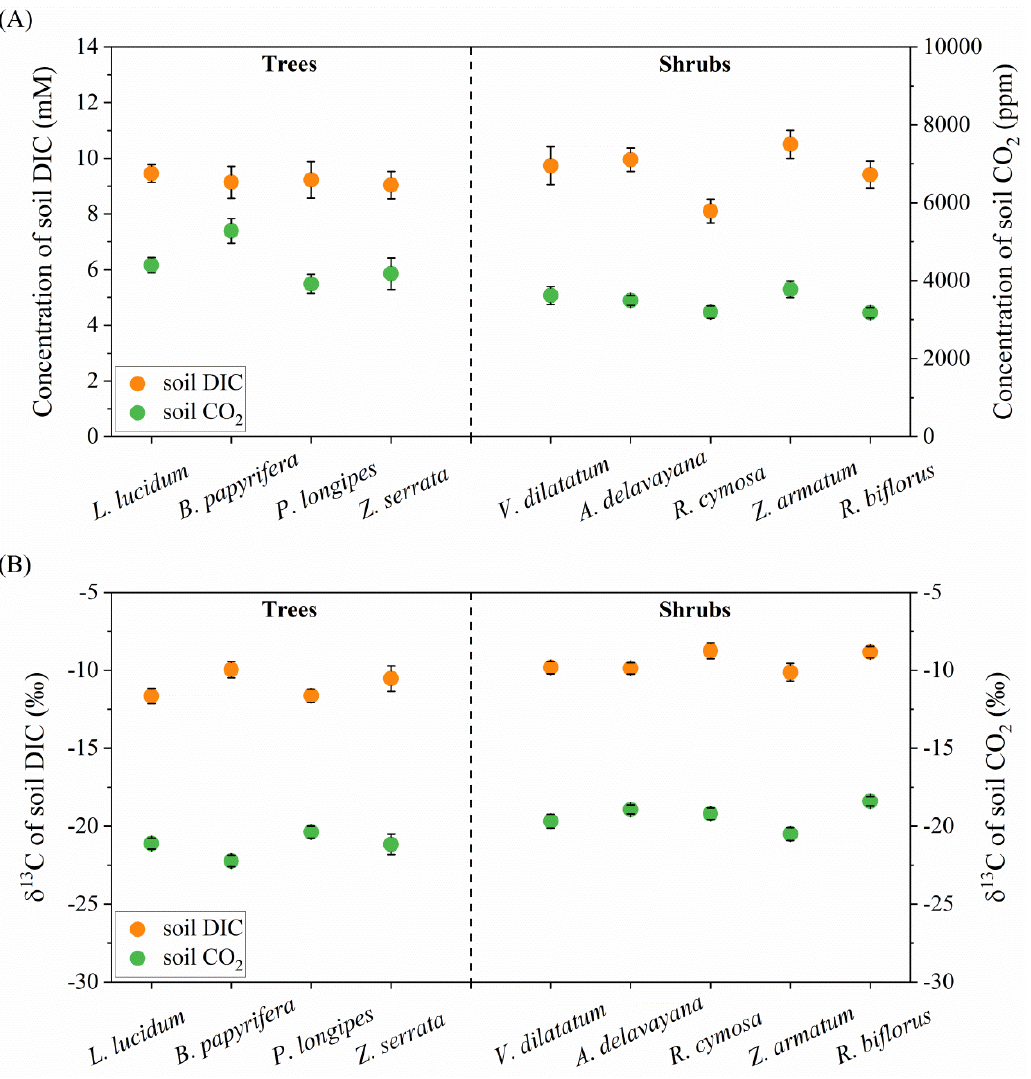
Figure 2. Concentrations ( A ) and δ 13 C ( B ) of soil DIC and CO 2 in the root zones of nine species across three altitudes. N = 4 for each species in the specific plot.